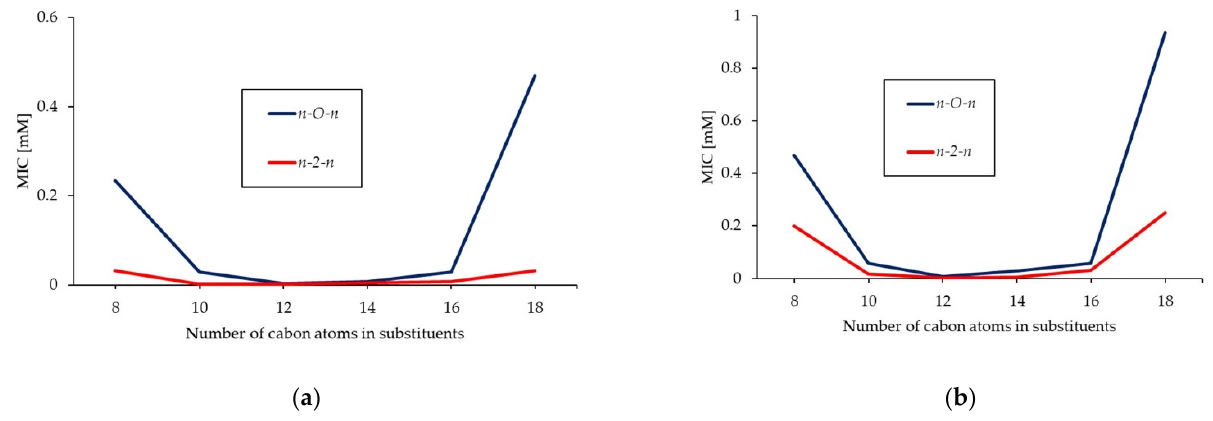
Figure 2. Quasi parabolic dependency of the antibacterial activity against S. aureus ( a ) and E. coli ( b ) on the hydrocarbon chain length for n - O - n (this research) and n -2- n [27].